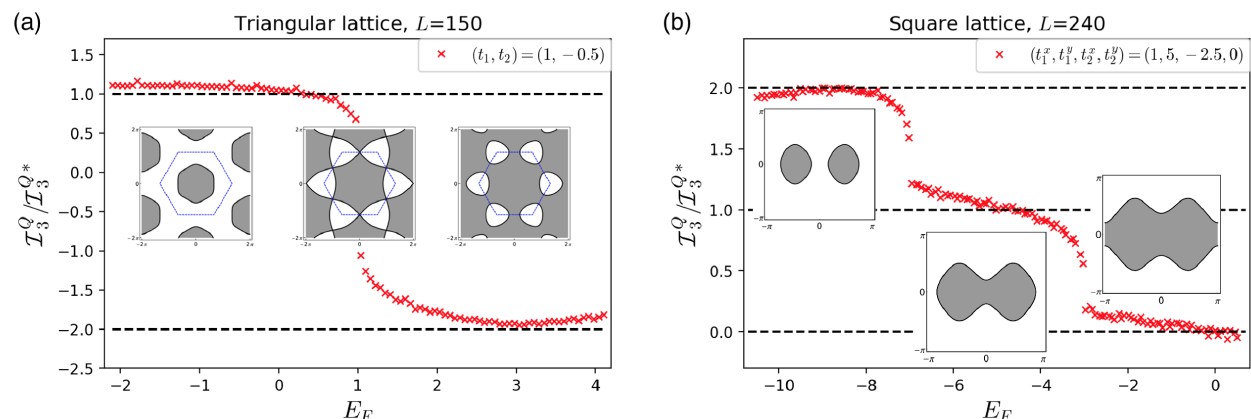
FIG. 7. Lifshitz transition as probed by the charge-weighted tripartite mutual information I Q 3 . Panel (a) shows a triangular lattice 1 to χ − 2 at E 1 . 0 . The reference I Q (cid:5) undergoing a topological transition from χ 3 is calculated at E F ¼ F ¼ F ¼ F ¼ χ (cid:5) ¼ 1 . Panel (b) shows a square lattice undergoing a topological transition from χ F ¼ 2 to χ F ¼ 1 at E F ¼ − 7 . 0 , and then from χ F ¼ 1 F 0 at E − 3 . 0 . The reference I Q (cid:5) − 5 . 0 , with χ (cid:5) to χ ¼ 1 . Insets display the filled Fermi sea (shaded in gray) 3 is calculated at E F ¼ F ¼ F ¼ F at different